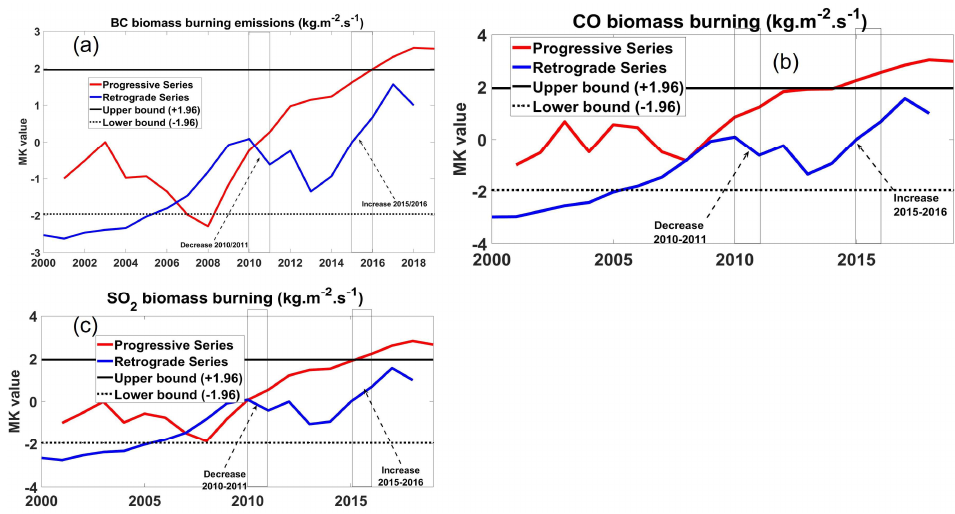
Figure 1. Trends in southern Africa for ( a ) BC biomass-burning emissions, ( b ) CO emissions, and ( c ) SO 2 biomass-burning emissions derived from sequential Mann–Kendal test statistics.